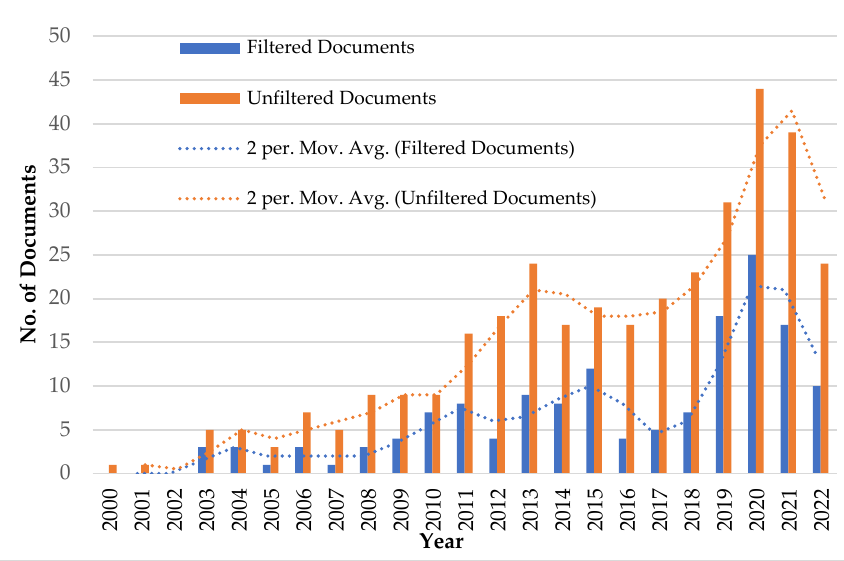
Figure 3. Distribution of publications each year: Unfiltered vs filtered documents .